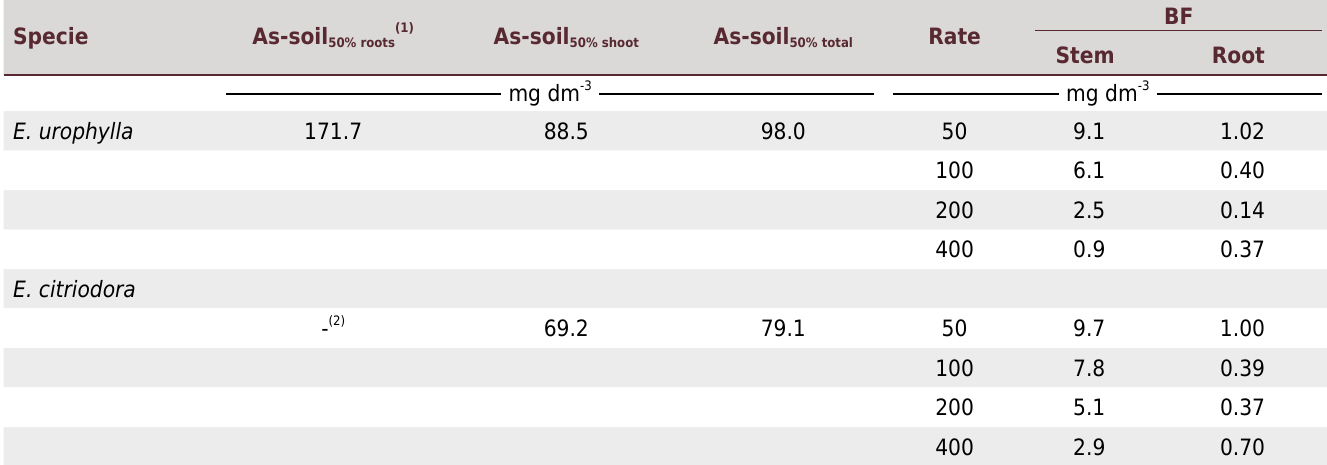
Table 4. Soil available arsenic which reduced in 50 % root (As-soil 50% roots ), shoot (As-soil 50% shoot ) and total (As-soil 50% total ) dry matter and As bioconcentration factors (BF) for seedlings of E. urophylla and E. citriodora, as influenced by arsenic rates applied to the soil